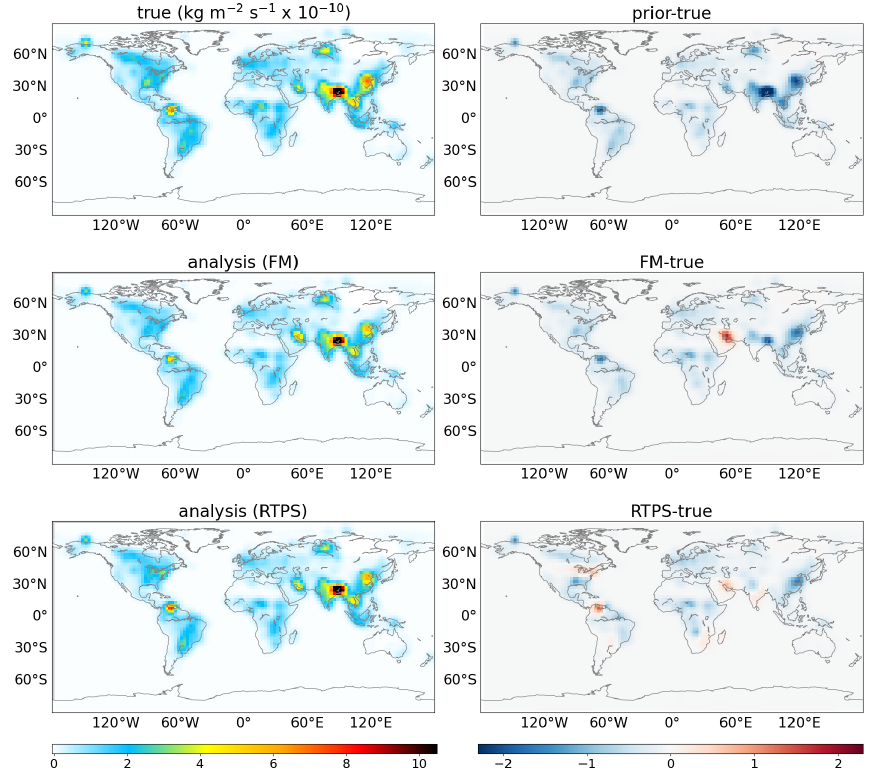
Figure 9. Monthly mean true (true; top left panel) and estimated (FM analysis; middle left panel, RTPS analysis; bottom left panel) CH 4 flux after assimilating column-averaged synthetic CH 4 concentrations (Fig. 6) during June using FM and RTPS inflation methods. The associated bias with prior and estimated fluxes is also shown (prior-true; top right panel; FM-true; middle right panel, RTPS-true; bottom right